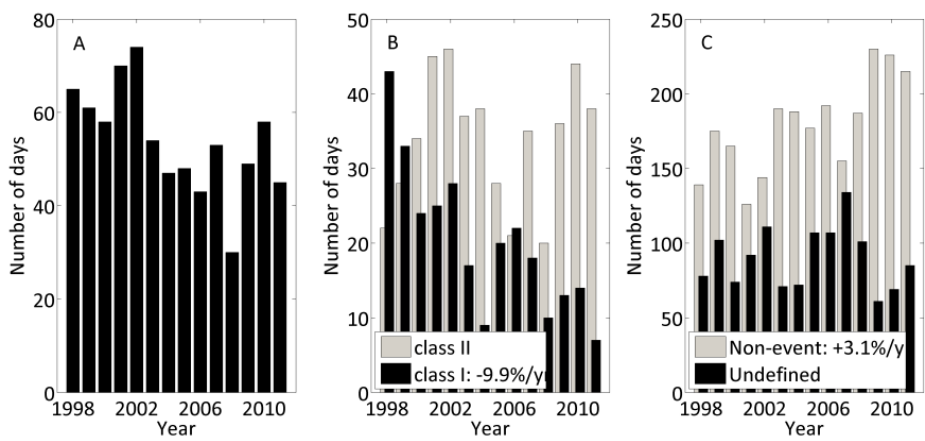
Fig. 5. Yearly number of event days (A) , divided into classes I and II (B) and yearly number of undefined and non-event days (C) . Figure 5 Yearly number of event days (A), divided into classes I and II (B) and yearly 3